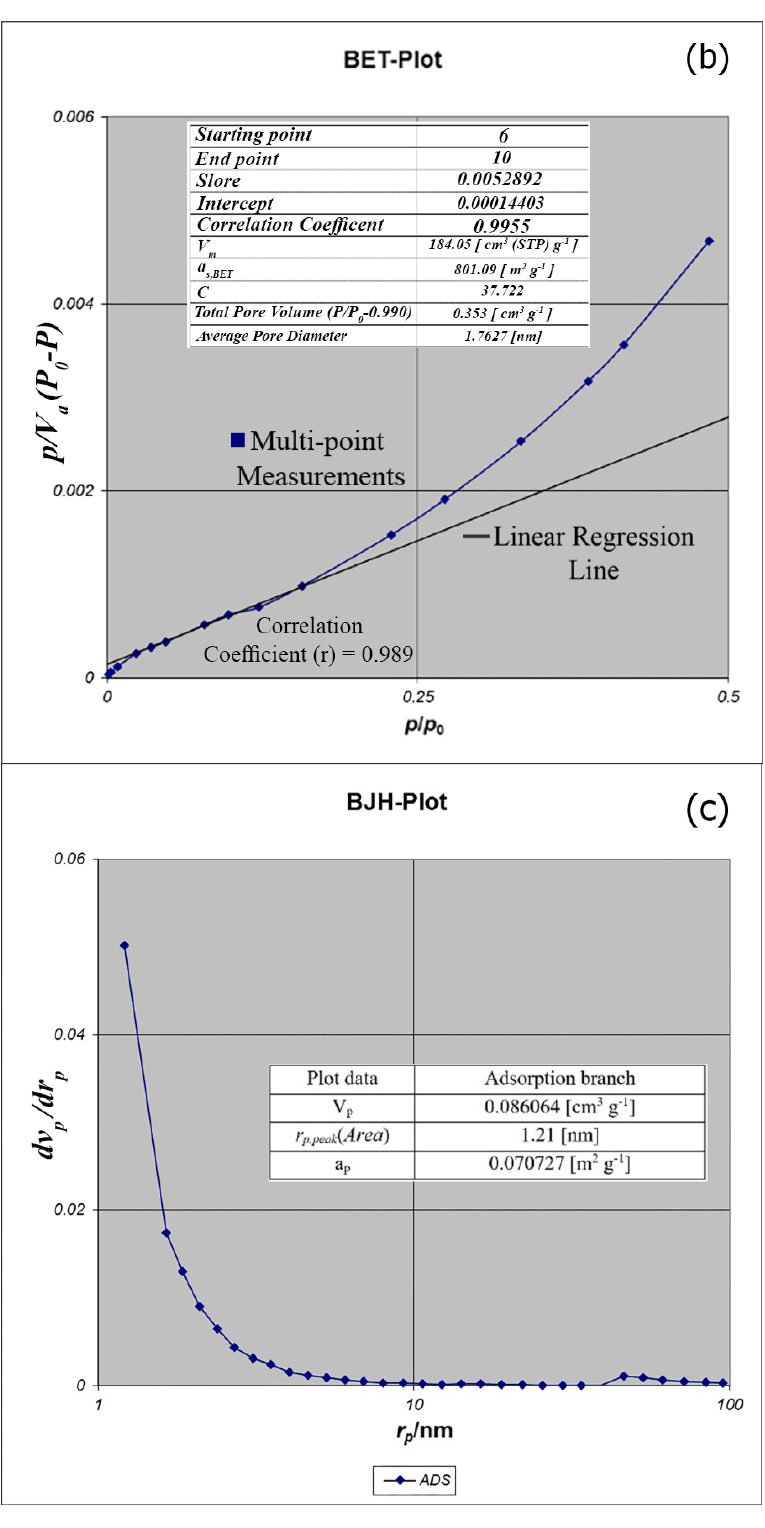
Figure 8. ( a ) Adsorption/desorption isotherms; ( b ) BET and ( c ) BJH plot of TC@MIL-100. TC and the DOX were separately loaded into nano-MIL-100 and analyzed by XRD and